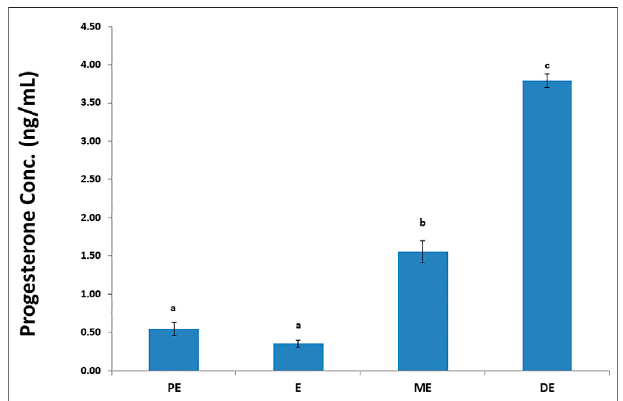
FIGURE 6 | Progesterone hormone concentration (ng/ml) during proestrus (PE), estrus (E), metestrus (ME), and diestrus (DE) stages of the buffalo estrous